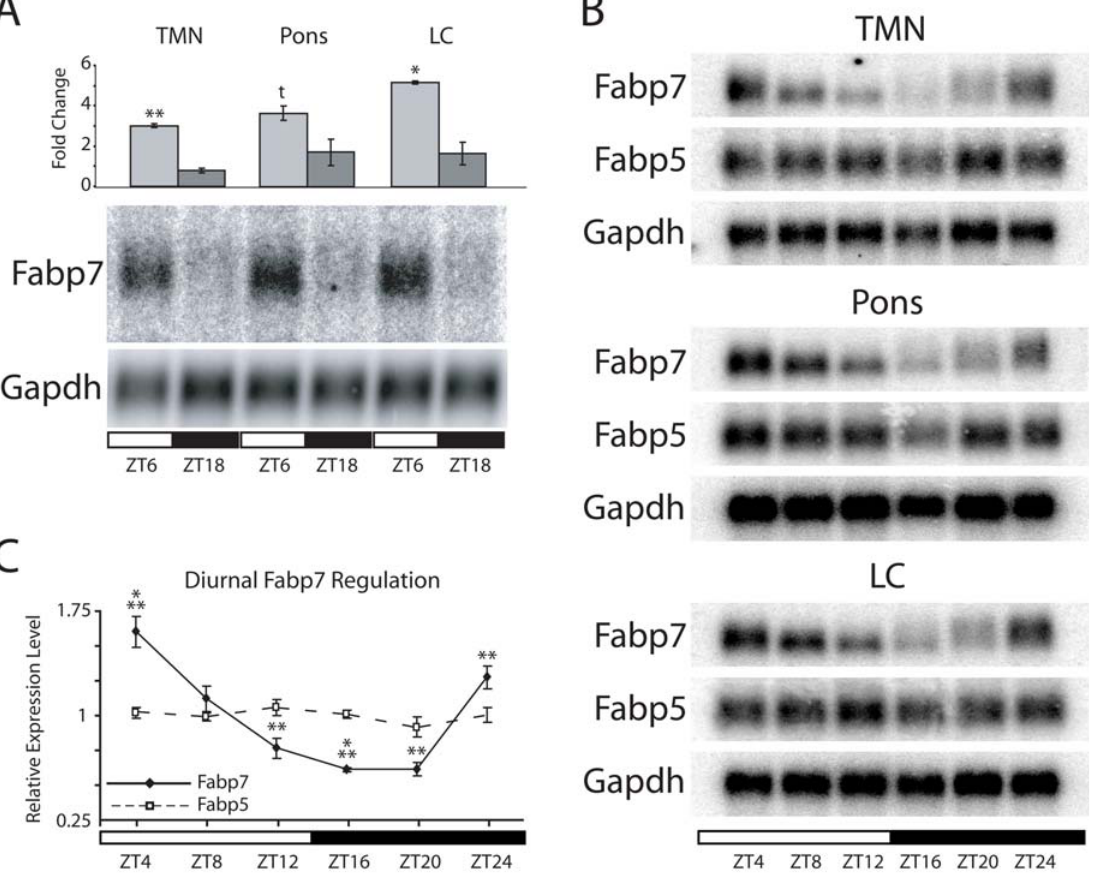
Figure 1. Fabp7 mRNA is diurnally regulated in brain regions involved in sleep and activity. A) RNA collected from tuberomammillary nucleus (TMN), pons and locus coeruleus (LC) subjected to Northern blotting revealed elevated levels of Fabp7 mRNA at Zeitgeber time (ZT) 6 compared to ZT18 (bottom panel). Glyeraldehyde-3-phosphate dehydrogenase (Gapdh) was used as a loading control. Graphic representation of Fabp7 expression normalized against Gapdh indicated 3 to 5 fold changes in mRNA levels (top panel); **p , 0.01, *p , 0.05, t=0.06 (t-test). Each time point represents 12 individual animals pooled. N =2–3 groups. B) Northern blot analysis of RNA collected every 4 hours showed diurnal changes in Fabp7 mRNA but not Fabp5. C) Collapsed data from B normalized with Gapdh indicated significant diurnal changes in Fabp7 mRNA across a 24-hour period but no changes in Fabp5 expression. One-way ANOVA, ***p , 0.001, **p , 0.01 (post-hoc Bonferroni). Each value represents the regional average + / 2 S.E.M. Each time point represents 3 individual animals